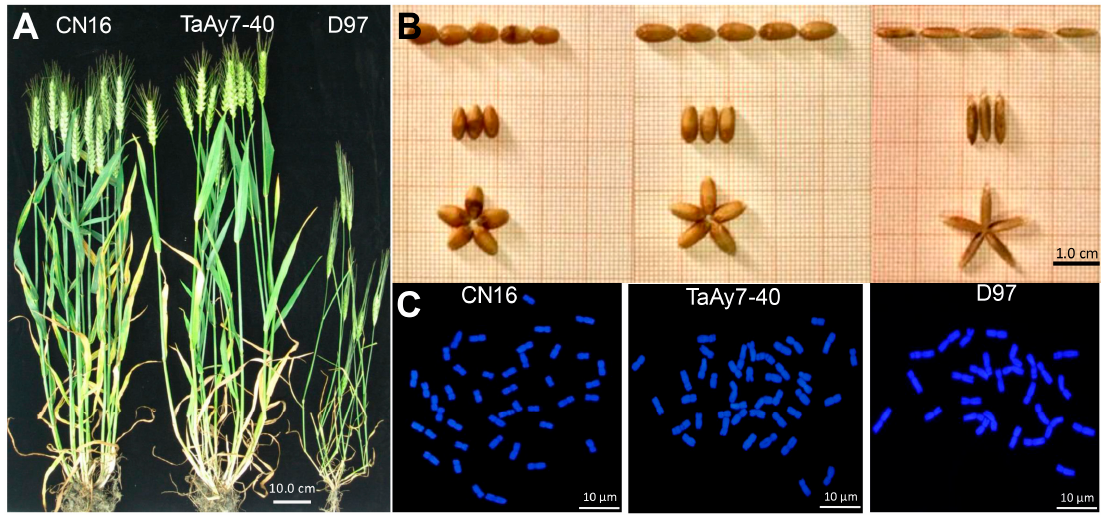
Figure 1. Morphological traits and chromosome patterns of introgression line TaAy7-40 and its parents CN16 and D97. ( A ) plants of TaAy7-40, CN16, and D97; ( B ) seeds of TaAy7-40, CN16, and D97; and ( C ) the number of root-tip chromosomes. Table 1. Comparison of morphological characteristics of TaAy7-40 and its parents CN16 and D97. Line